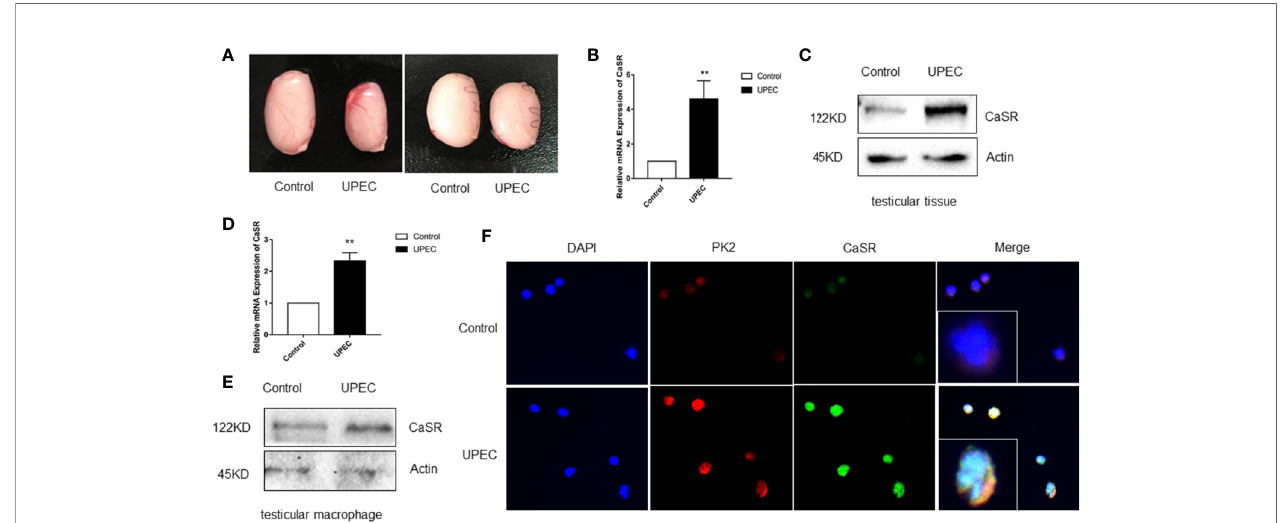
FIGURE 2 | CaSR expression was increased in UPEC-infected rat TM. (A) Comparison of testicle size between the saline control and UPEC infection groups ( n =5/ group). (B) CaSR mRNA expression in the testis tissues of the normal saline control and UPEC infected groups ( P < 0.01) ( n =5/group). (C) CaSR protein content in the testis tissues of the two groups of rats. (D) The expression of CaSR mRNA in the testes of two groups in primary macrophages ( P < 0.01) ( n =5/group). (E) CaSR protein expression in the primary testicular macrophages of the two groups of rats. (F) Localization of CaSR in primary testicular macrophages. ** P < 0.01 ( t